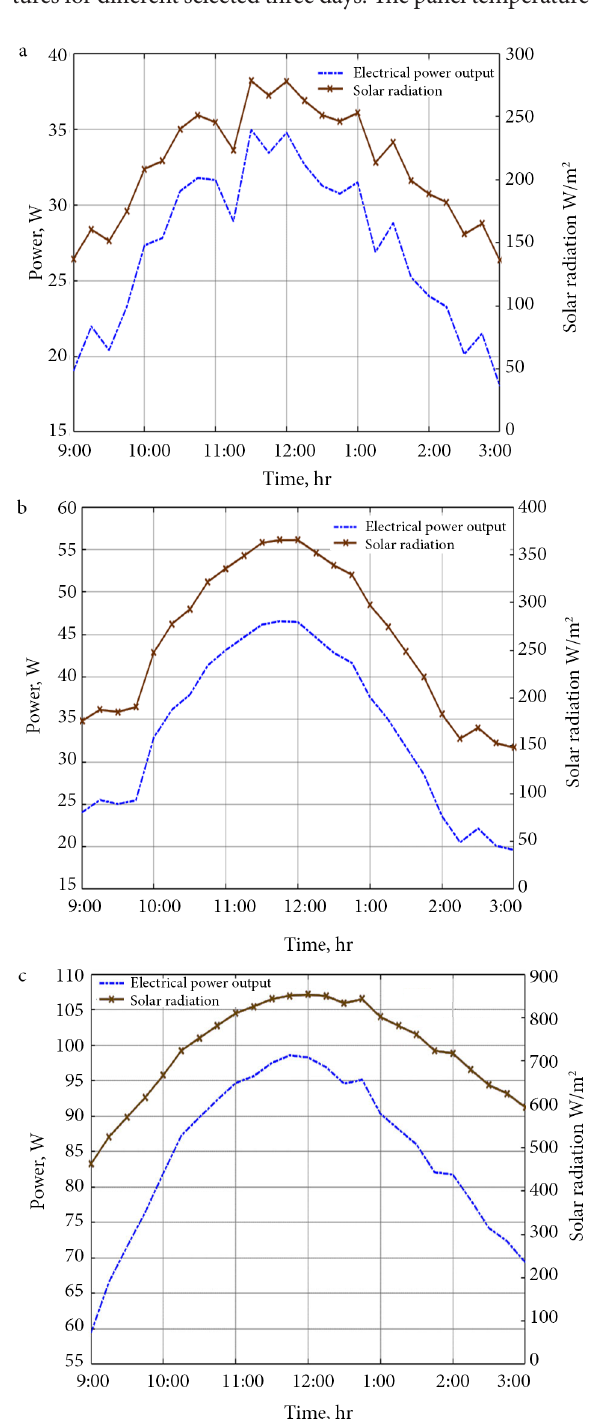
Figure 9. Useful energy variation and recorded solar radiation histories on: a − Nov. 28 th 2018, b − Feb. 3 rd 2019,